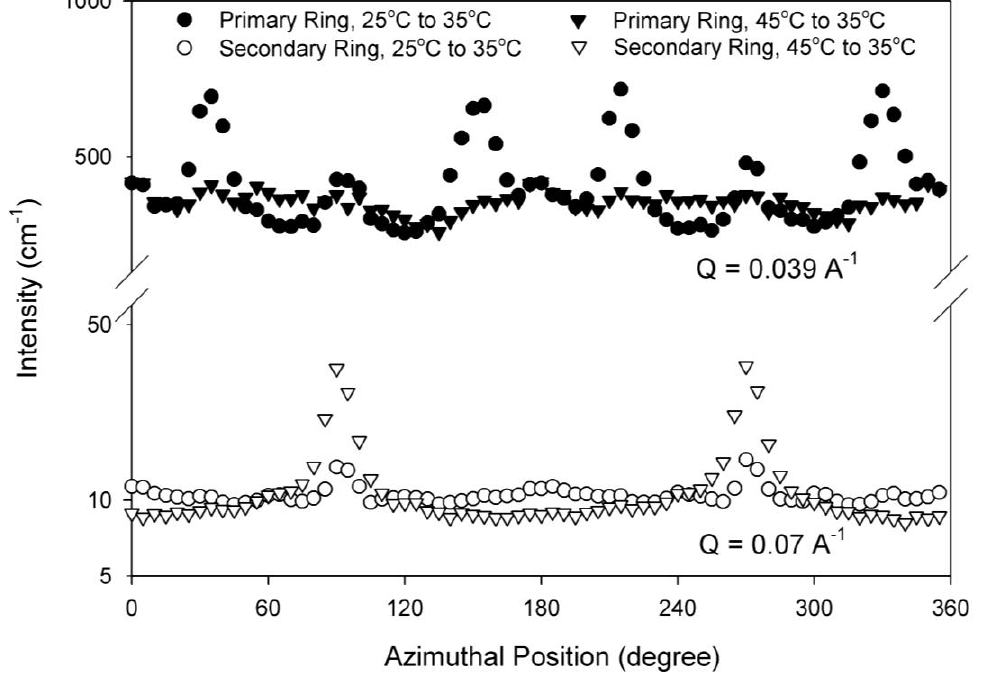
Figure 10. Intensity as a function of azimuthal angle for scattering in Figure 9(B) and 9(E) in the primary ring (Q = 0.039 A −1 ) and secondary ring (Q = 0.07 A −1